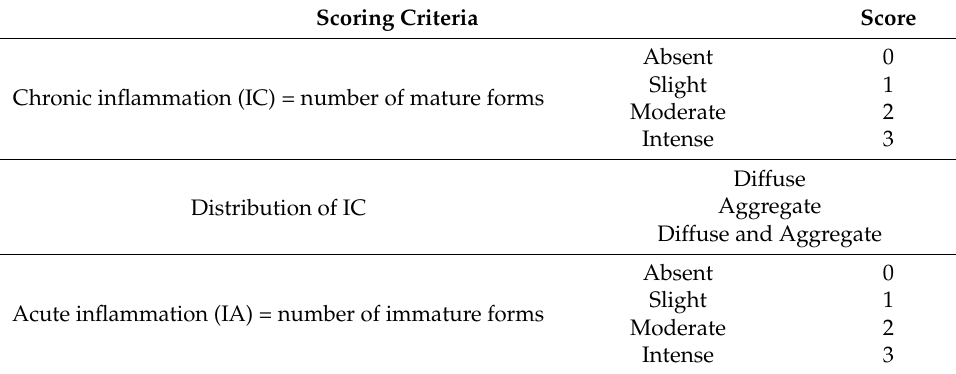
Table 2. Scoring criteria of measured inflammation parameters. Scoring Criteria